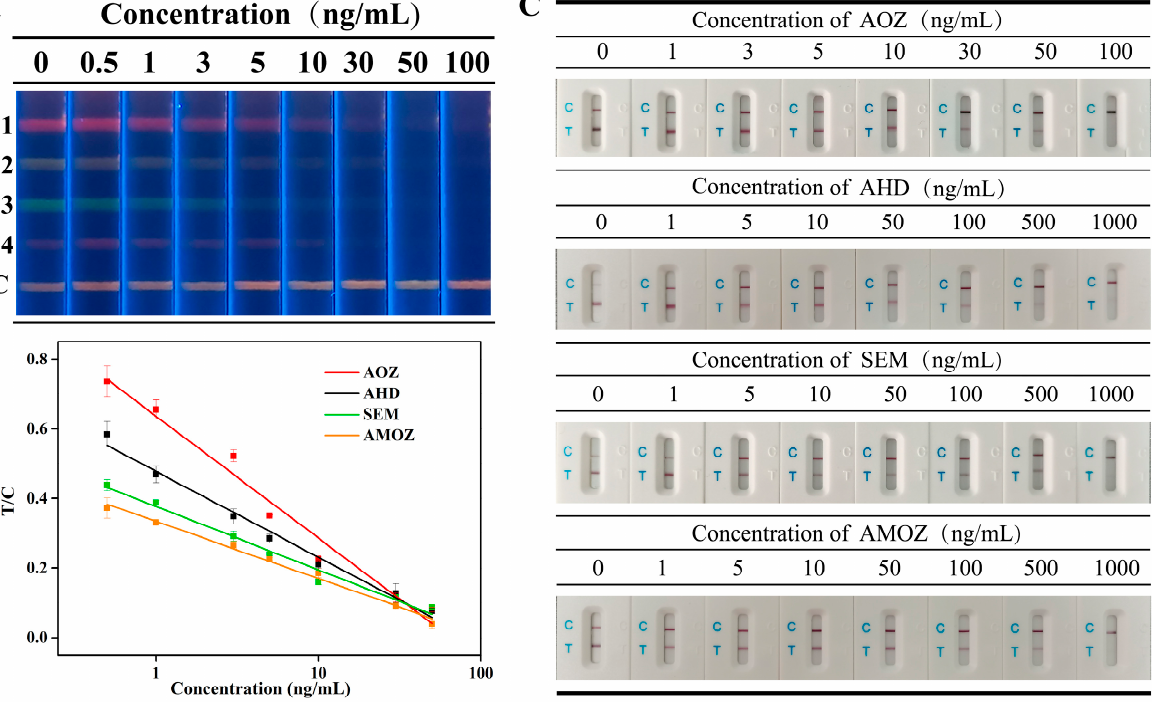
Figure 4. ( A ) Fluorescent image of mICA strip under UV light for detection of AOZ (T1), AHD (T2), SEM (T3), and AMOZ (T4), ( B ) calibration curves of analytes, and ( C ) Commercial colloidal gold test strips for analyte